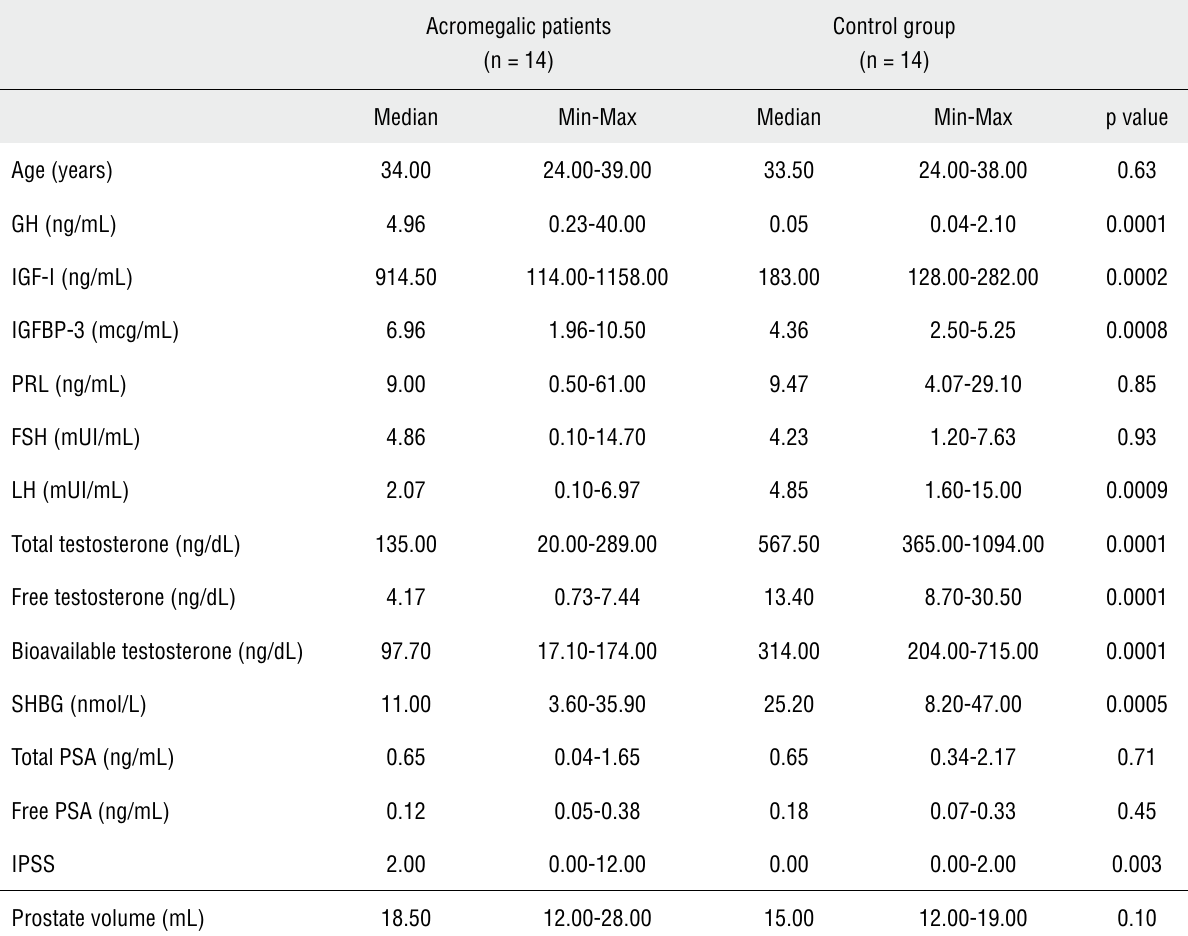
Table 1 - Characteristics of acromegalic patients at baseline and control group (< 40 years-old). Acromegalic